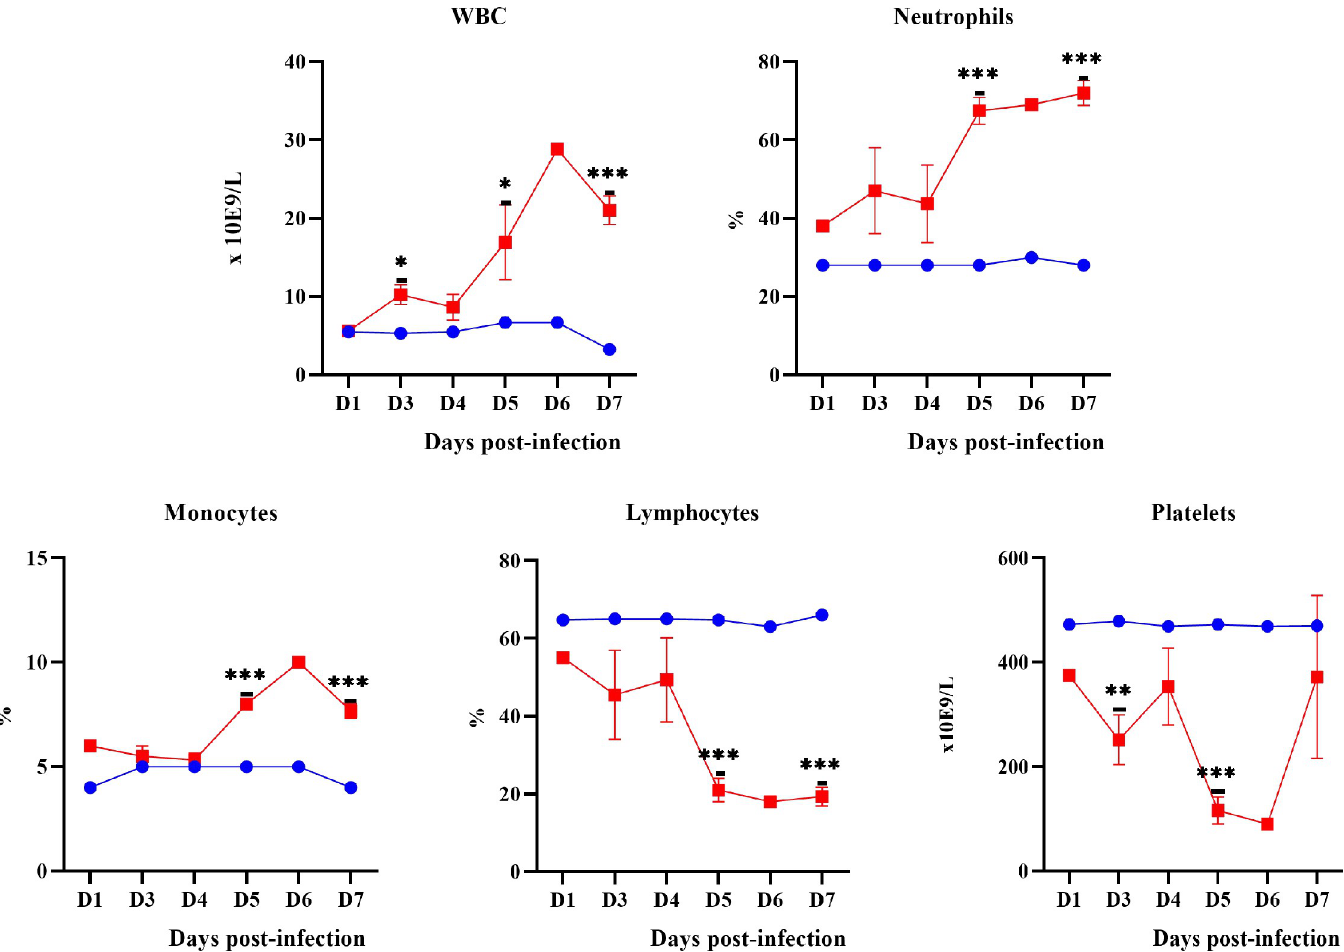
Fig 7. The pattern of WBC, neutrophils, monocytes, lymphocytes and platelets levels in control (blue line) and infected hamsters (red line). D1-D7: Day 1 to day 7. � P � 0.05, �� P � 0.01, ��� P � 0.001.